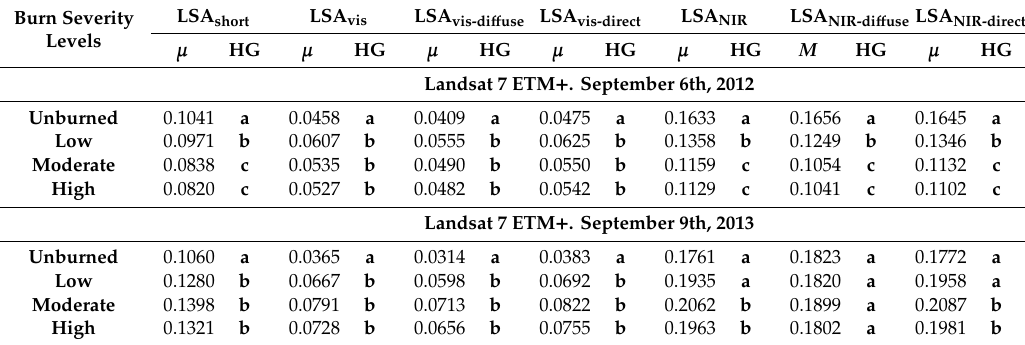
Table 1. Fisher’s Least Significant Di ff erence test for the post-fire LSA images (LSA short , LSA vis